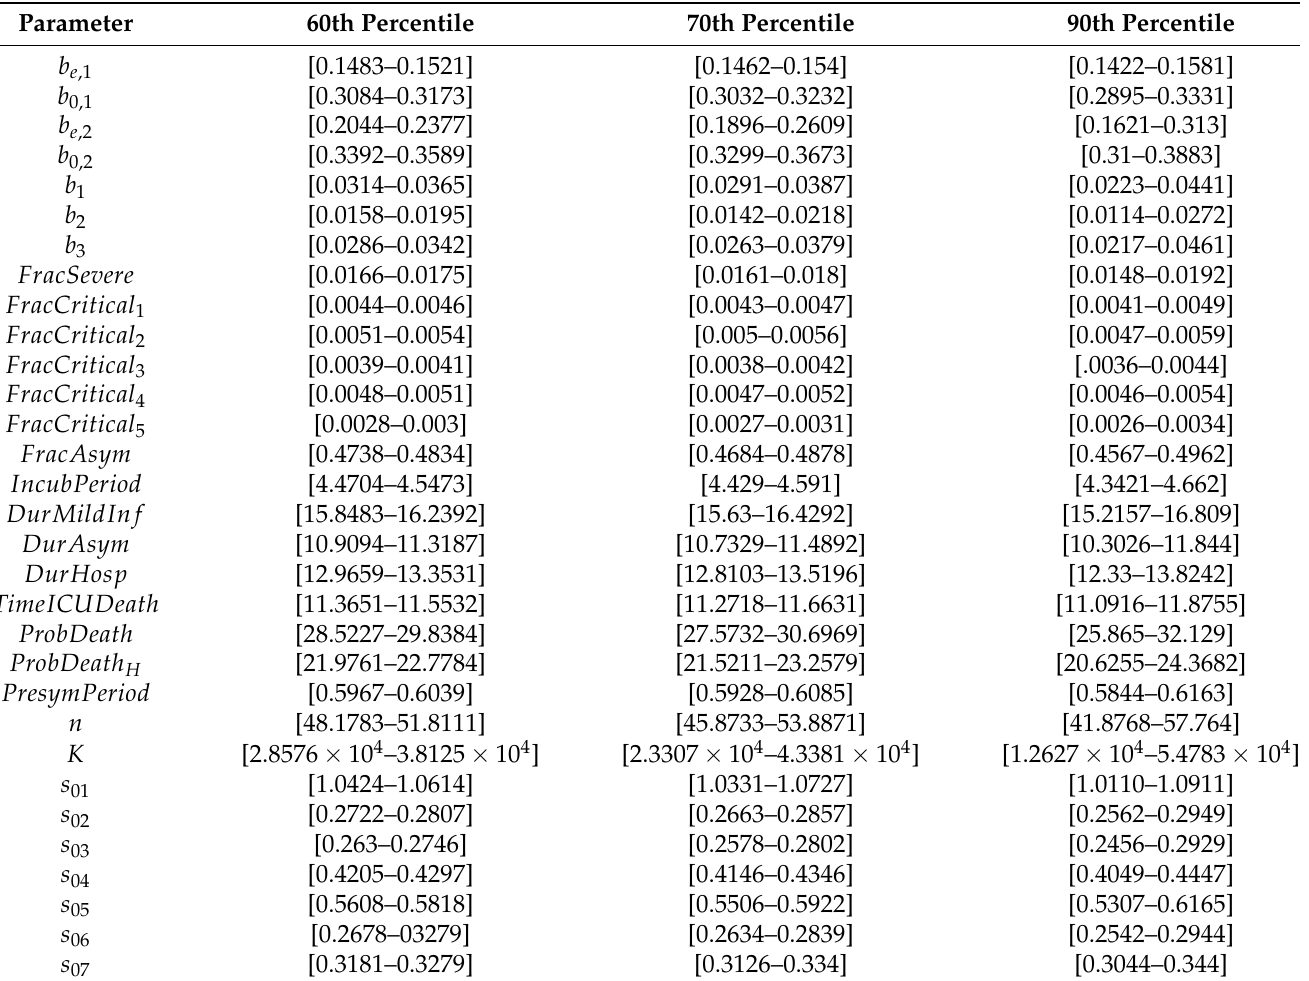
Table A1. CRC results for Umbria. The columns show the 60th, 70th, and 90th percentile of the probability density function (pdf) of the parameter vector returned by CRC in the last iteration, for one of the realizations.